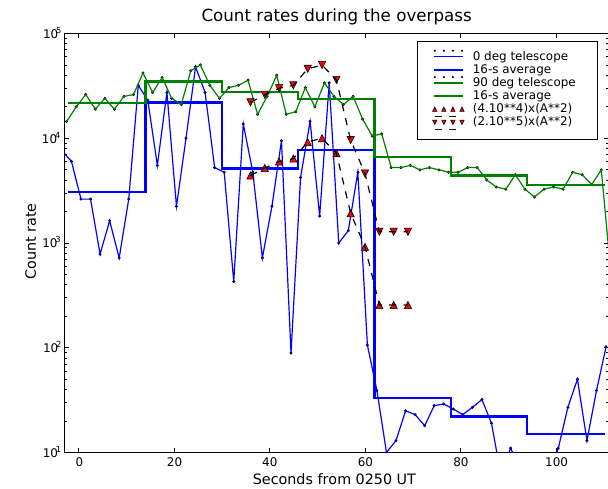
Fig. 14. Track of NOAA-16 across the distribution of 38.2MHz ra- diowave absorption derived from the imaging riometer at Kilpisj ¨ arvi (K). The position of the EISCAT VHF radar (V) is also shown.